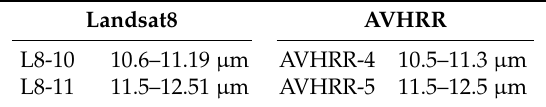
Table 4. Two thermal infrared channels of Landsat8 and